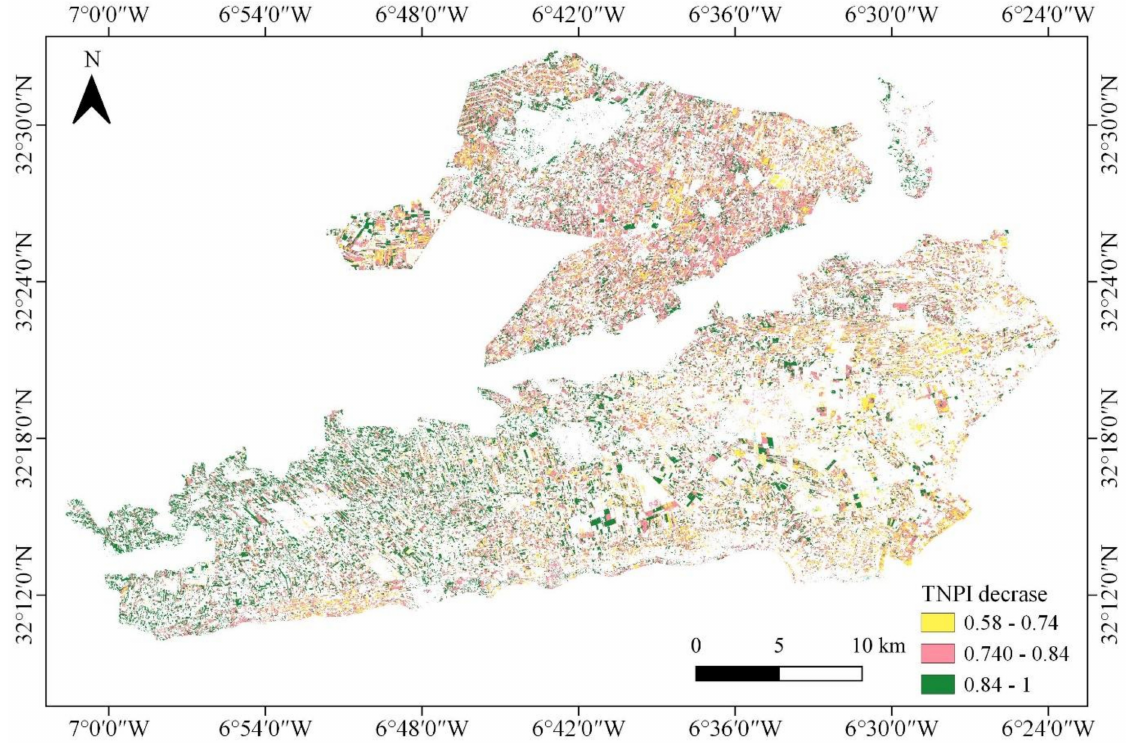
Figure 14. Crop growth increase based on TNPI during two phenological phases (heading and maturity).